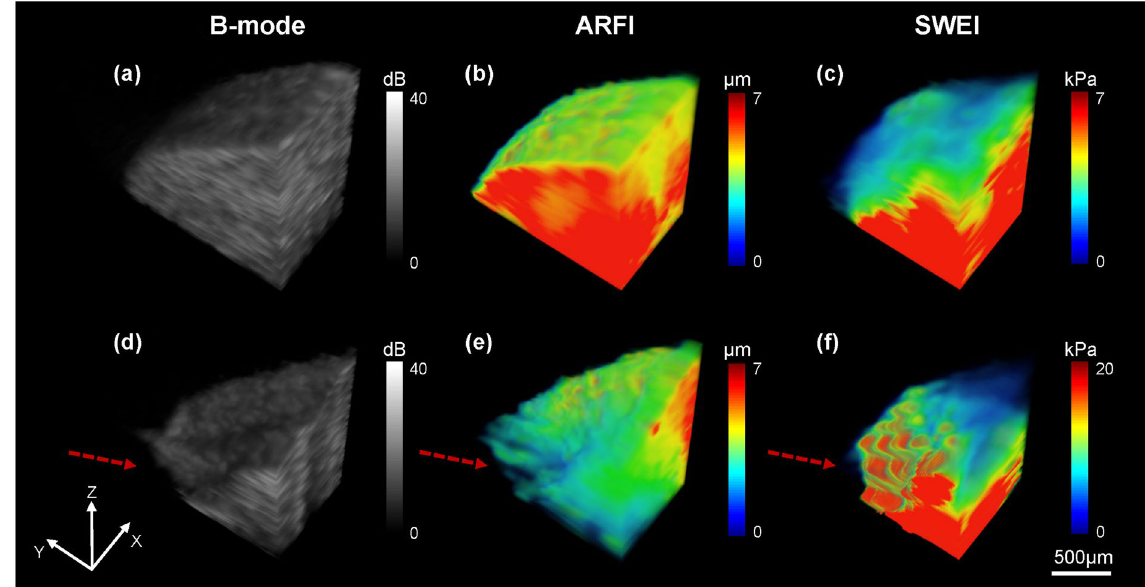
Figure 5. Ex vivo 3D visualizations of the chicken liver. ( a – c ) Normal liver and ( d – f ) Liver with artificially induced “fibrosis” using formalin solution. Volume dimensions (xyz) are 1.2 mm × 2 mm × 1.8 mm. The red arrows in ( d–f ) indicate the site of formalin